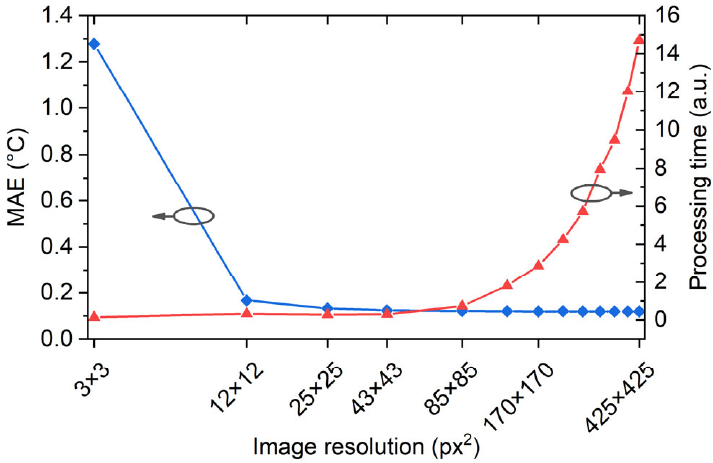
Figure 6. MAE for the linear regression model depending on the size of the input thermal image (blue line). Reconstruction time for a sample depending on the size of the input image (red line).